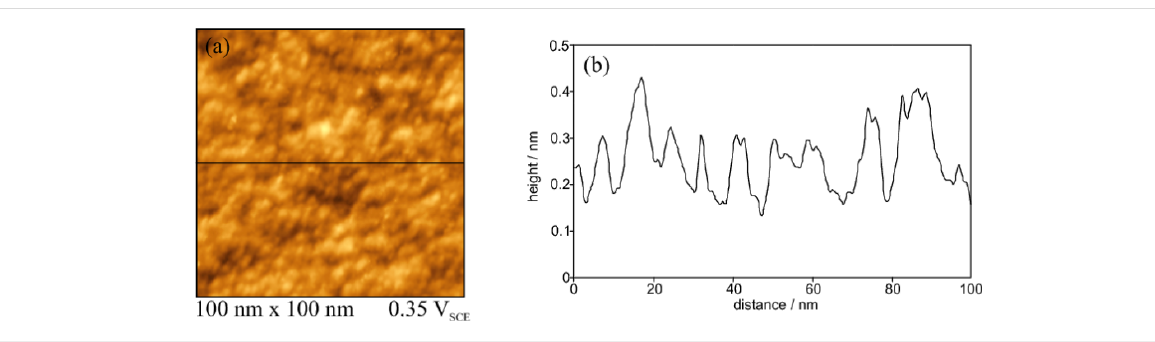
Figure 3: in situ STM image of H 2 -cooled Ir(210) in 0.1 M H 2 SO 4 at 0.35 V. (b) Height profile along the line shown in (a).